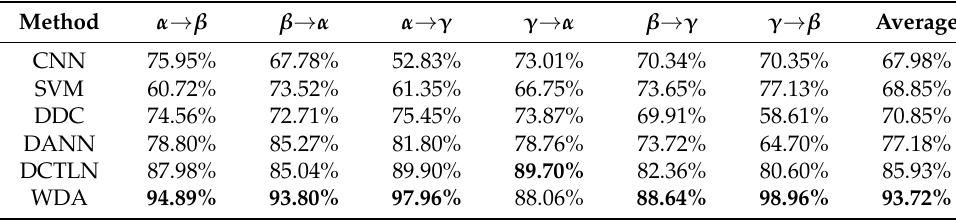
Figure 10. Comparison accuracies of different methods. Table 6. Results of different transfer result.